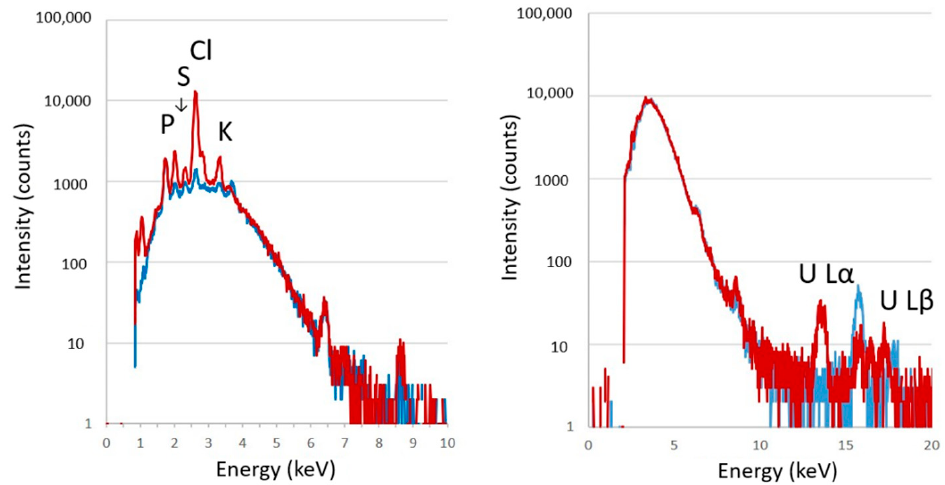
Figure 3. PIXE spectra of S3 cells obtained by scanning at areas in Figures 4 and 5. Blue line, control. Red line, uranium-treated. Scanning area, 50 µ m × 50 µ m. Integrated charge, 0.2 µ C. Beam size of 1 µ m × 1 µ m with the Si (Li) detector ( left ) and CdTe detector ( right ).